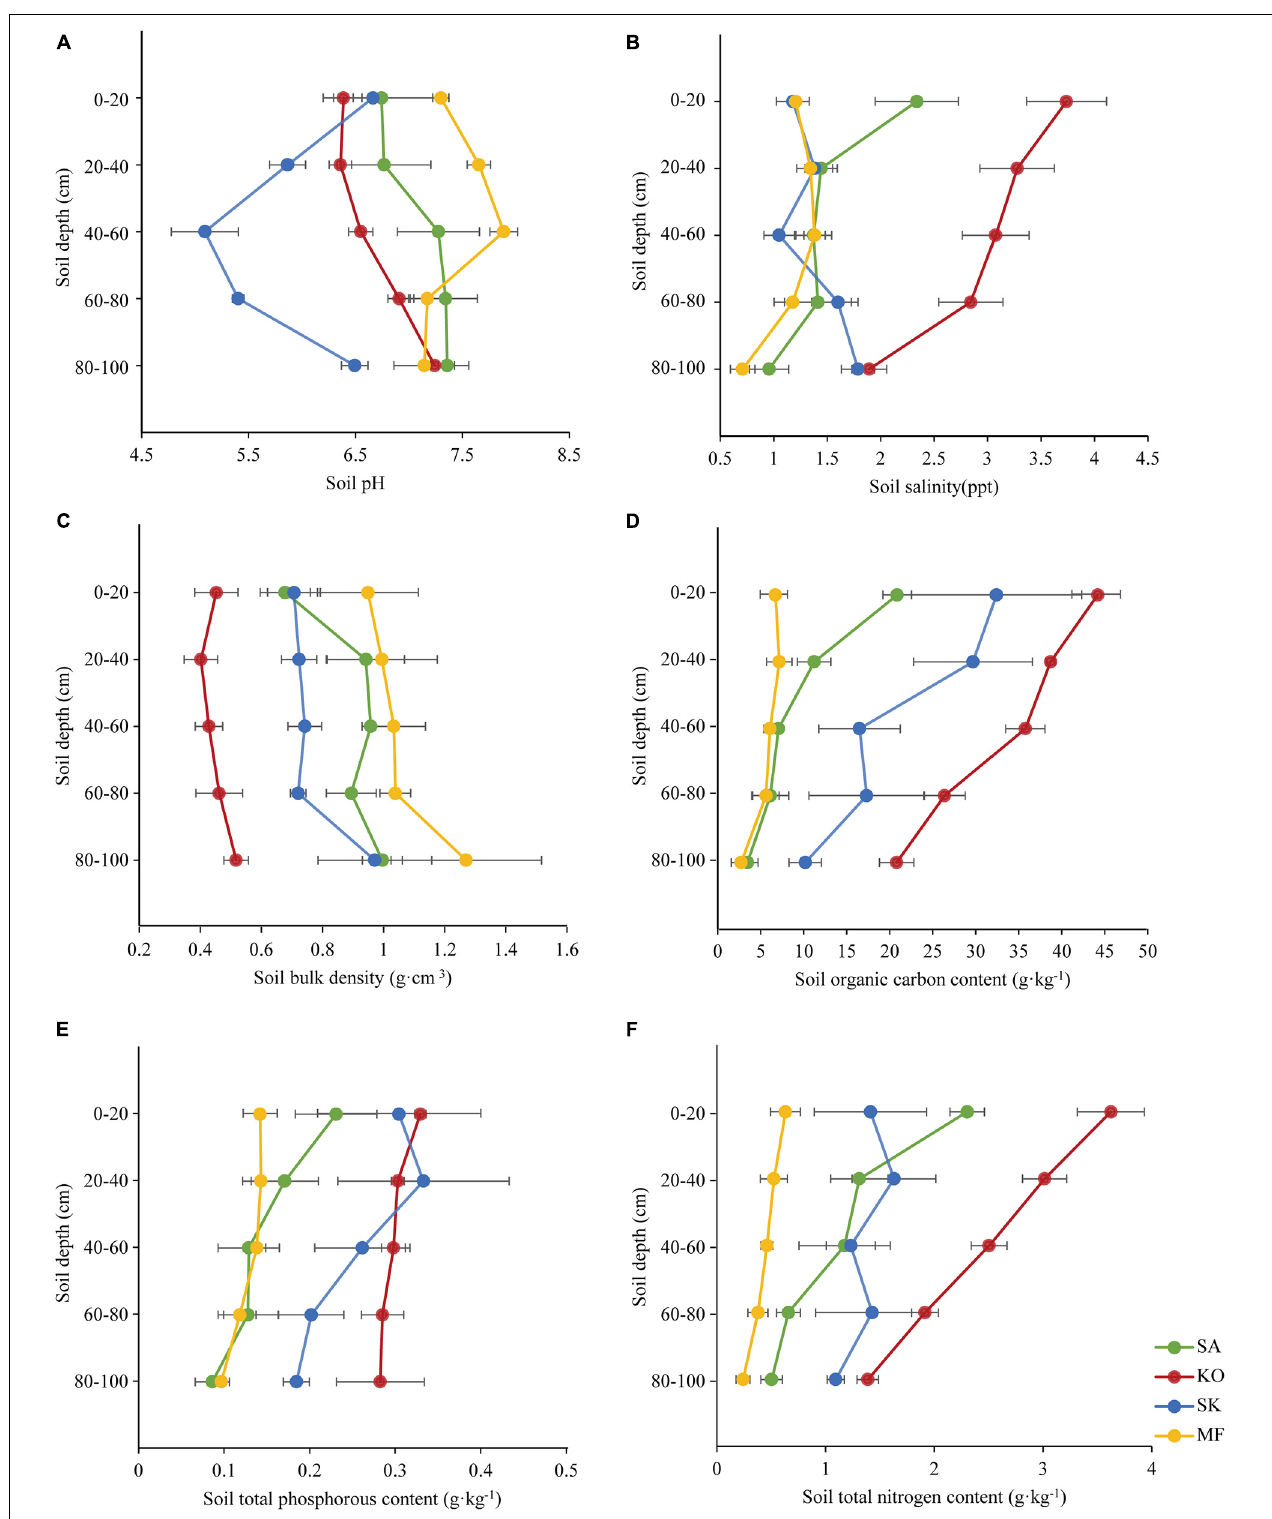
FIGURE 2 | Soil properties and their vertical distribution in K. obovata (KO), S. apetala (SA) monocultures, mixed plantation (SK), and mudflat (MF) at Hanjiang River Estuary, south China. (A) Soil pH. (B) Soil salinity. (C) Soil bulk density. (D) Soil organic carbon content. (E) Soil total phosphorous content. (F) Soil total nitrogen content. Error bars represent 1SE, and SE represents standard error ( n = 5). Data of soil pH, salinity, bulk density, and soil organic carbon content in K. obovata and S. apetala monocultures and the mudflat are from He et al. (2018).